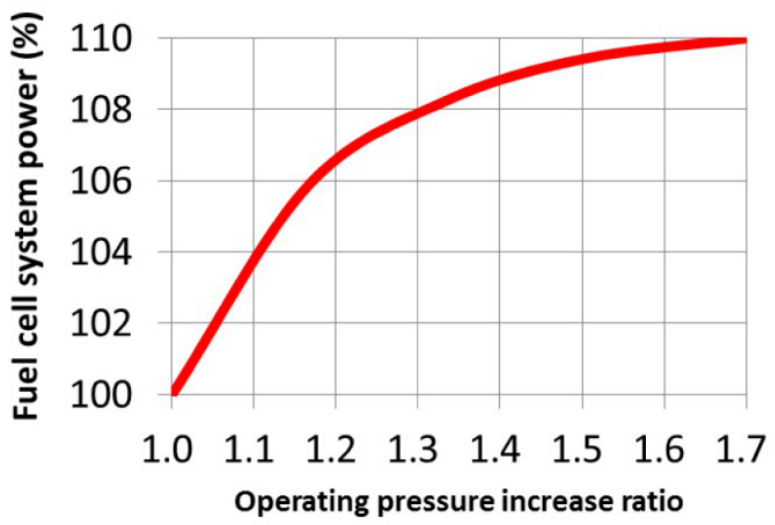
Figure 1. Influence of the operating pressure on the fuel cell output power.